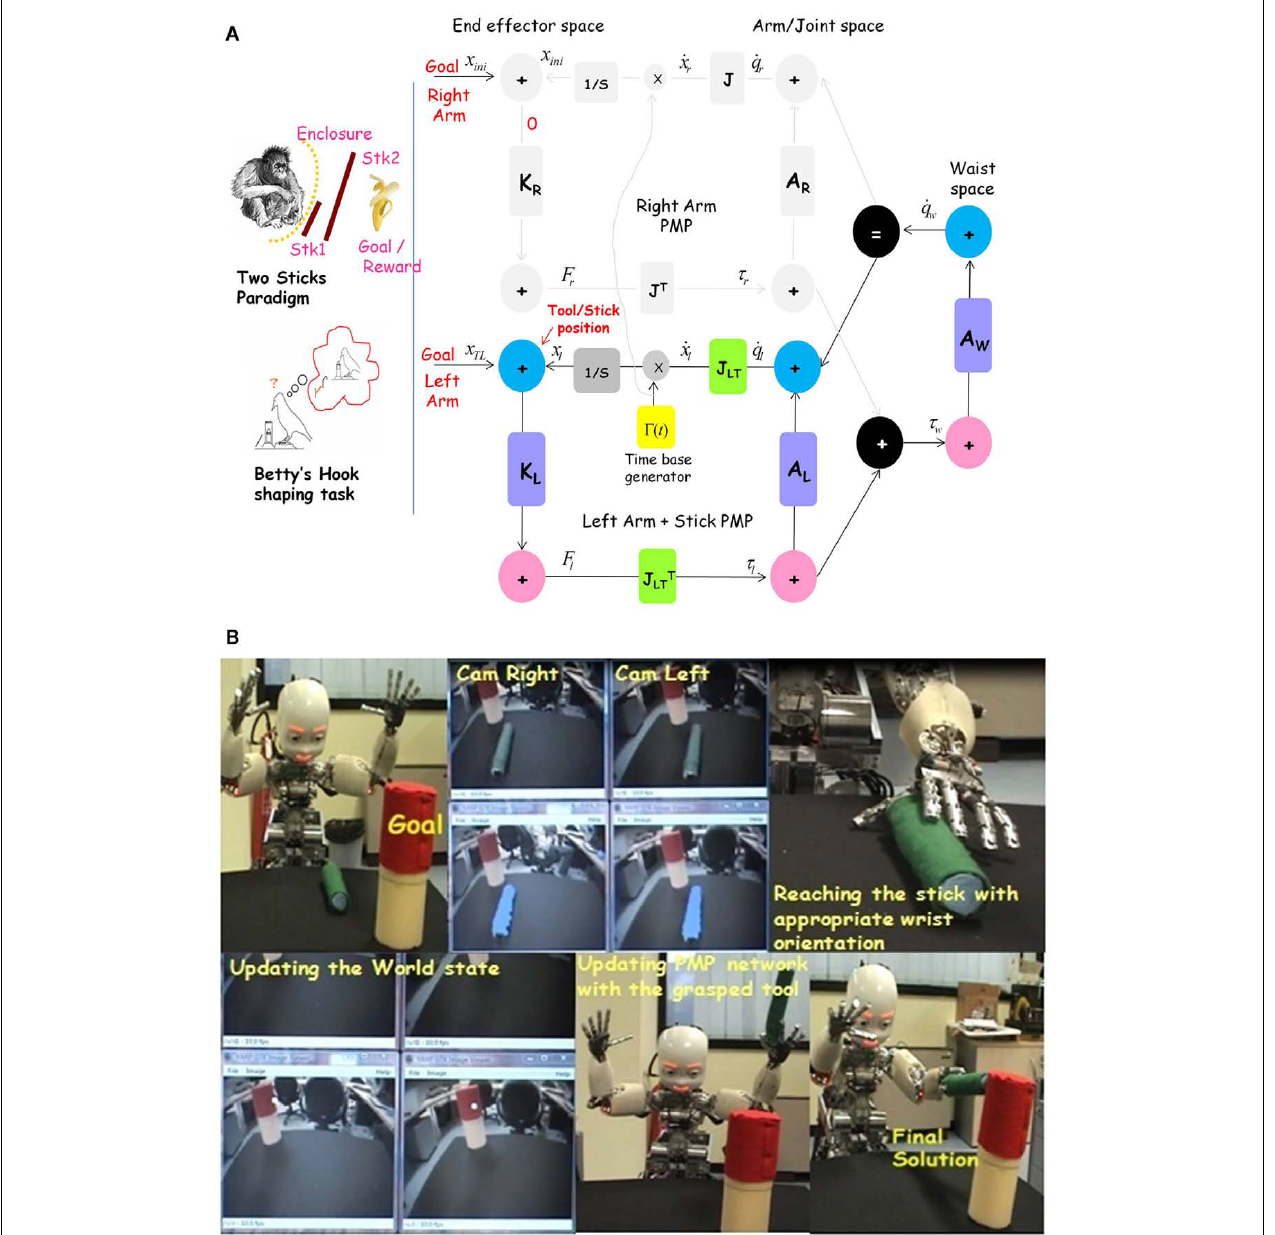
cylinder using the PMP network of (A) . In (A) , since the tool is coupled to the left arm, the right arm network is shown deactivated (goal = initial condition, force field in the right arm network is 0). Since the coordinated tool is the most distal part of the resulting PMP network, goals act on the tool.The field generated by the discrepancy between goal and tool position is mapped into an equivalent torque field by the transpose Jacobian ( J LTT ).This torque field is mapped into joint rotation patterns for the left arm by the Admittance matrix. The Jacobian J LT now transforms this information into next incremental update in the tool position in the end effector space (tool is the end effector now).This process of incremental updating of every node in the PMP network continues till the time the force field in the left arm network is also zero (i.e., the tool tip reaches the target). (B) Shows snapshots of iCub performing the sequence of actions, reasoning and exploiting the available tool (green stick) in order to realize the otherwise unrealizable goal (i.e., reaching the red